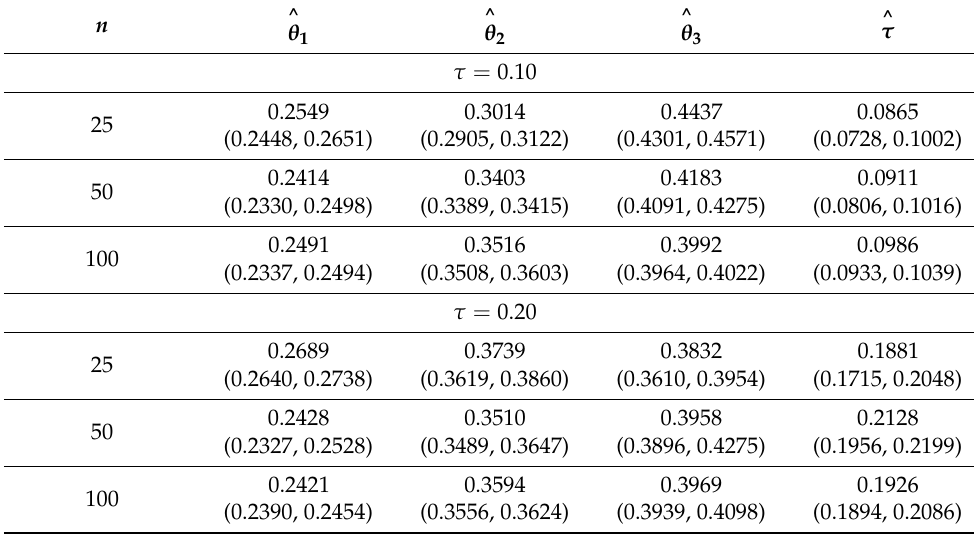
Table 3. Estimates of worth parameters and associated 95% credible intervals (in parenthesis) for pre-defined experimental